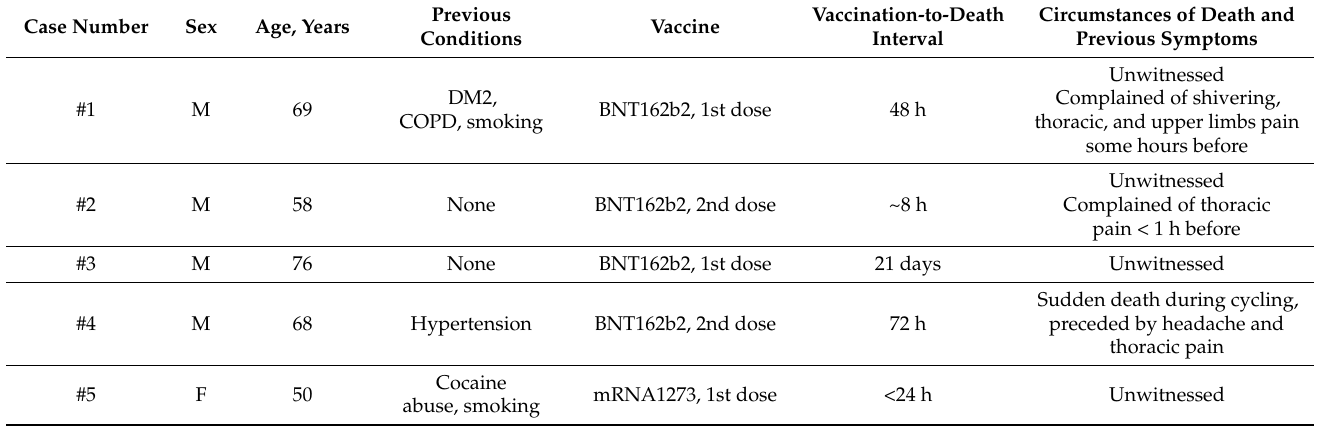
Table 1. Clinical characteristics and mode of death.